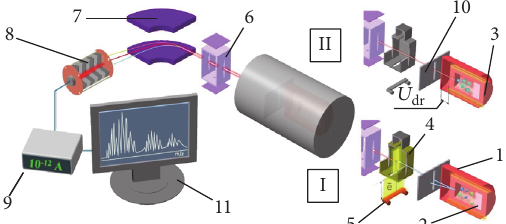
Figure 1: Scheme of the mass spectrometer (taken from [15]). I—EI mode; II—TE mode. The details are given in text.